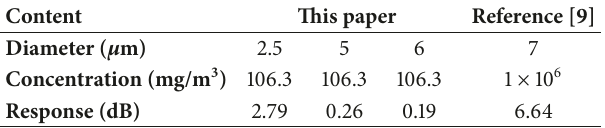
Table 1: Summary of the responses shown by each sensor to the different concentrations.